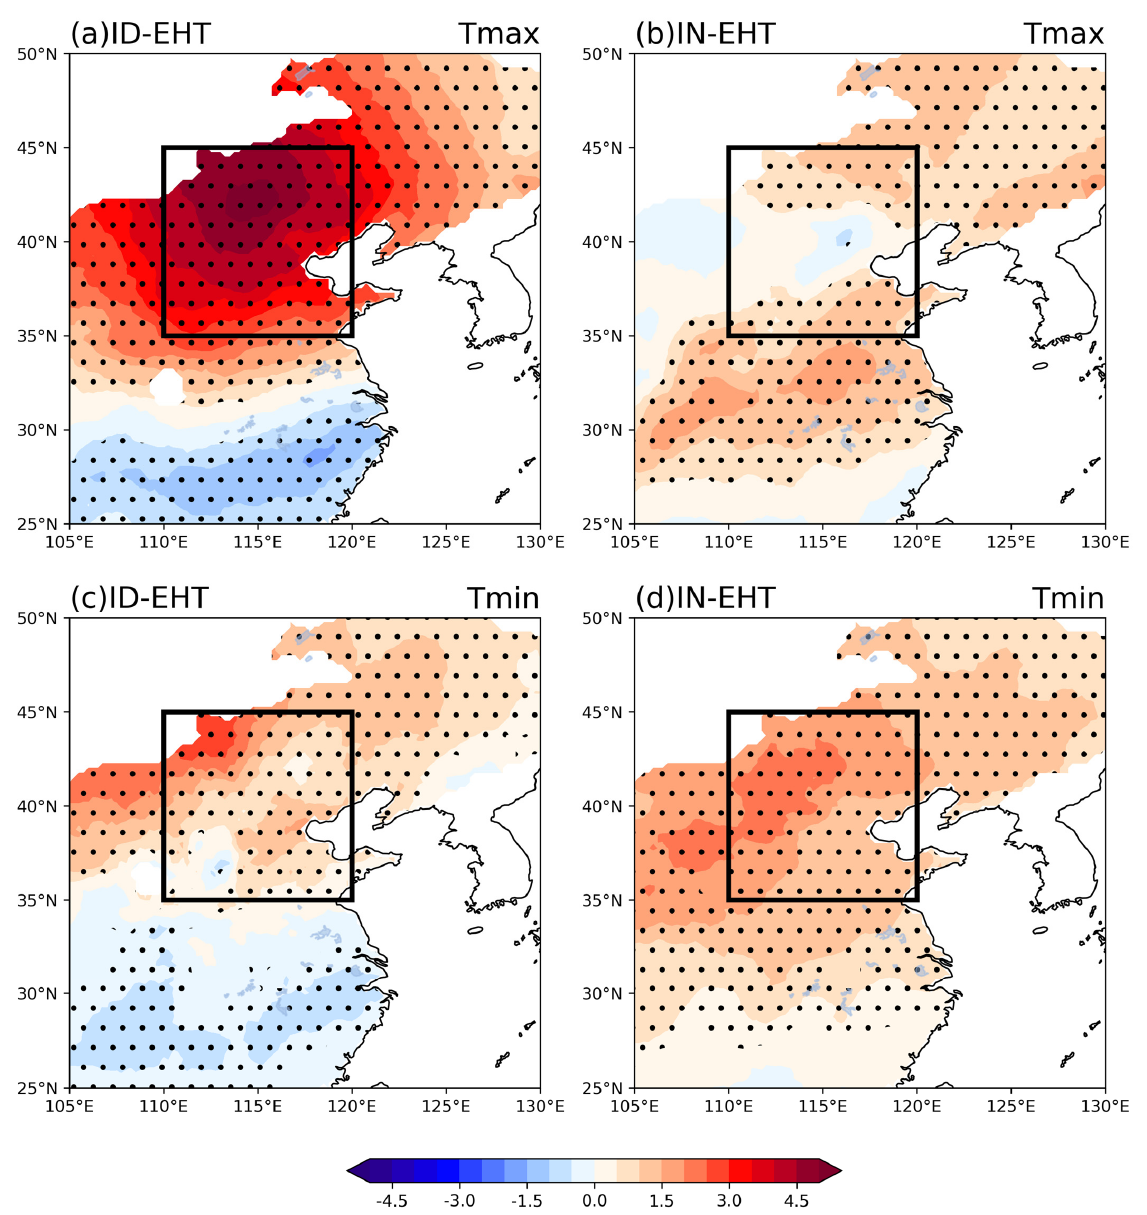
Figure 1. Composite anomalies of Tmax for ( a ) ID-EHT, ( b ) IN-EHT; ( c , d ): the same as ( a , b ) but for Tmin anomalies (shading; units: °C). Black dots indicate the anomalies significant at the 95% confidence level.